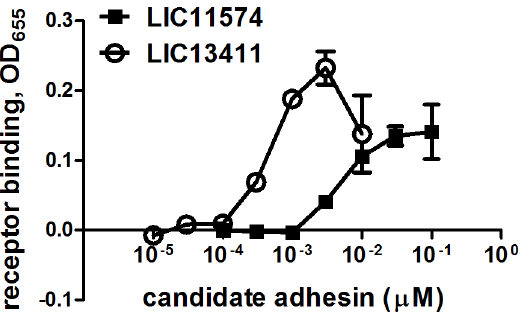
Figure 5. L. interrogans candidate adhesins LIC11574 and LIC13411 bind to the host protein VE-cadherin. L. interrogans proteins, LIC11574 and LIC13411 were expressed as fusions to MBP (diluted 1 6 10 2 5 –0.1 m M) and incubated for 1 hr with 0.01 m M VE- cadherin or control BSA immobilized on a Linbro plate. The unbound recombinant proteins were washed off and bound proteins were quantified by ELISA using an anti-MBP antibody. Attachment to VE- cadherin is expressed as the OD reading at 655 nm minus BSA and no receptor (or ‘‘plastic’’) binding. Results indicate that attachment of LIC11574 ( K D =7.6 6 2.5 nM) and LIC13411 ( K D =0.4 6 0.2 nM) to VE- cadherin, but not to BSA, is dose-dependent and saturable.